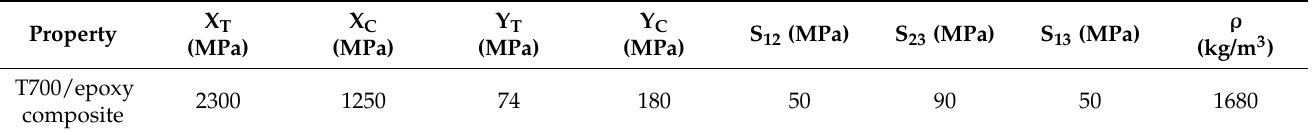
Table 5. Material properties of the T700/epoxy composite.